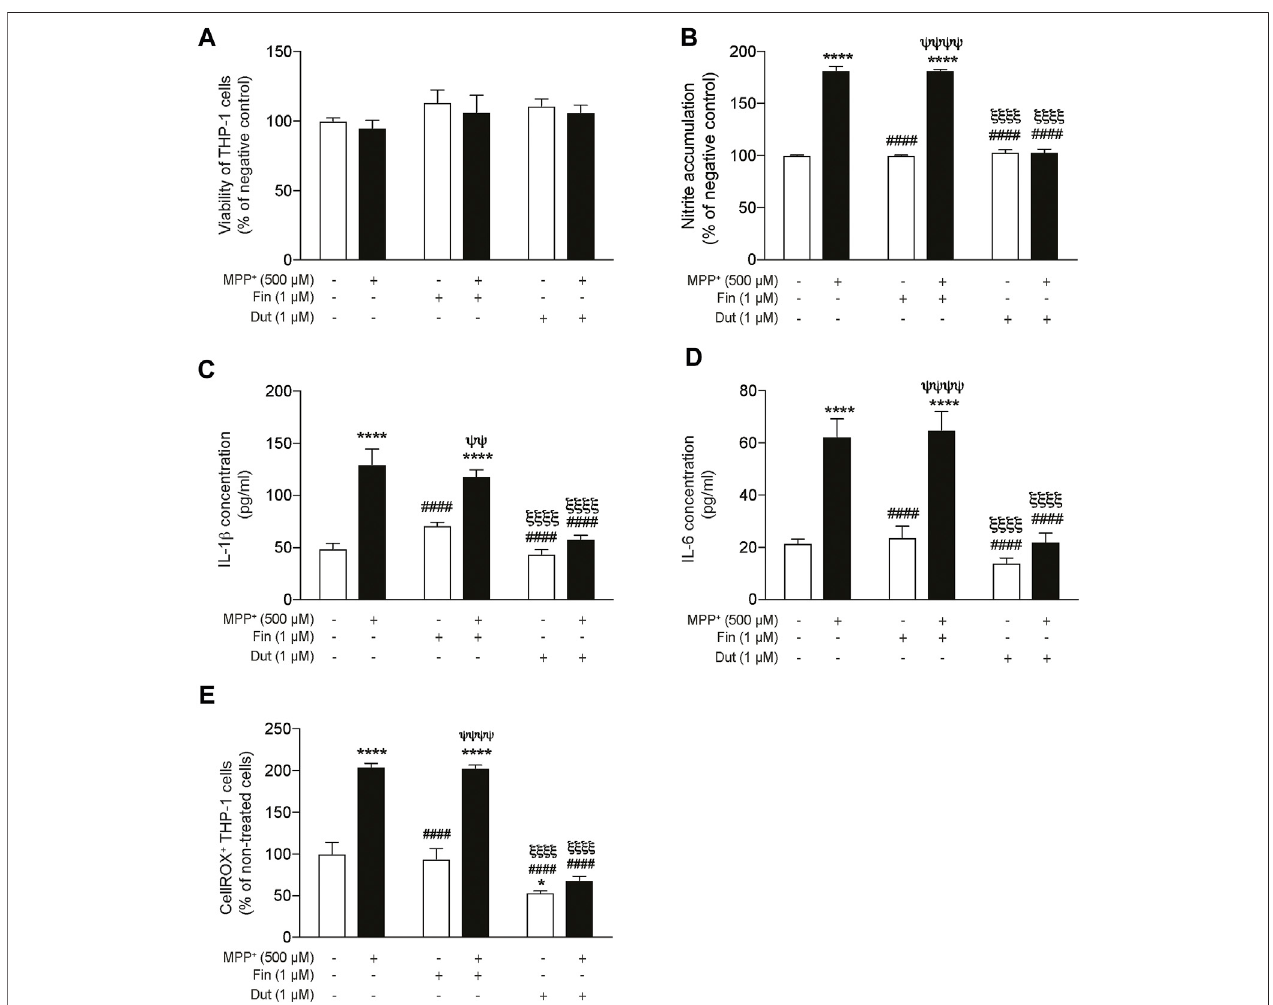
FIGURE6| Signi fi cantreduction ofproin fl ammatory markers bydutasteridebutnotby fi nasteride treatment inTHP-1 cellsfollowing MPP + stimulation.Nitric oxide (NO), IL-1 β , and IL-6 production was measured in the supernatant of THP-1 monocytic cells treated with fi nasteride (Fin) or dutasteride (Dut) in the presence or the absenceofMPP + .Histograms show (A) THP-1cellviabilityquanti fi cation(MTT assay)and (B) NOaccumulationbyTHP-1cells(Griess assay)aspercentage ofnegative control, (C) IL-1 β and (D) IL-6cytokineproductioninpg/ml,and (E) numberofpositiveTHP-1cellstotheoxidativestressmarkerCellROXOrangeaspercentageof cells. Results are the mean of three experiments. * p < 0.05 and **** p < 0.0001 compared to control; #### p < 0.0001 compared to MPP + treatment; ψψ p < 0.01 and ψψψψ p < 0.0001 compared to Finasteride only; ξξξξ p < 0.0001 compared to MPP + + fi nasteride.